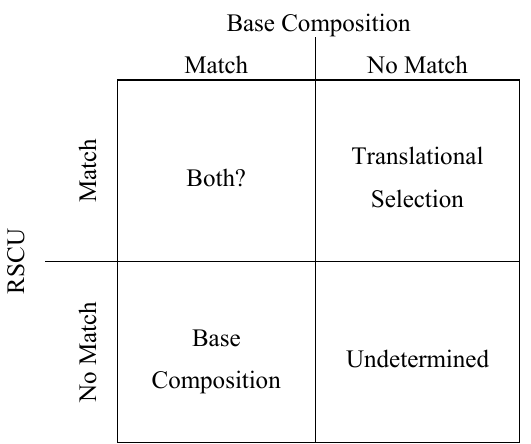
Table 1. Possible explanations for codon usage bias when the codon usage bias (CUB) of a gene of interest match or fail to match the genomic base composition and relative synonymous codon usage (RSCU) of a set of reference genes. For viruses, the comparison would be between the CUB of the viral genes and the CUB of their